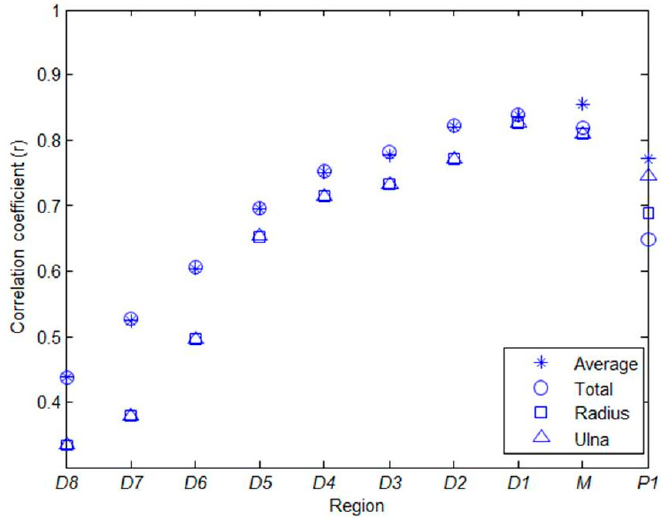
Figure 3. Correlation coefficient values between BMD f and R Gca / ta ( type ), where type ∈ { radius , ulna , total , average } and G ∈ { D 1, D 2, D 3, D 4, D 5, D 6, D 7, D 8, M , P 1}. Table 2. Correlation coefficient r values according to the type and the regions of M and D 1 .